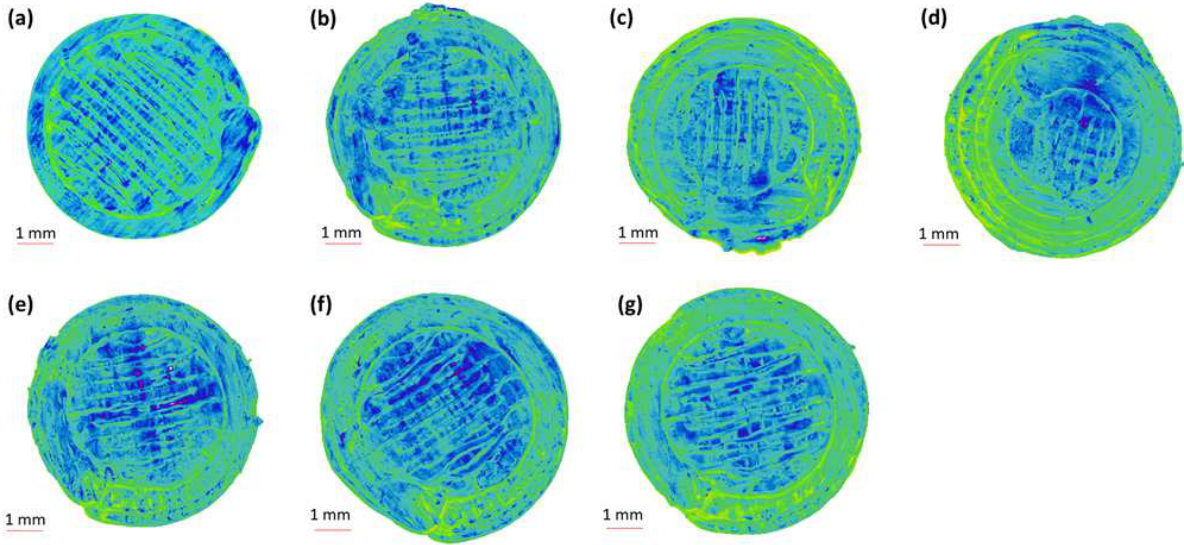
Figure 6. Two-dimensional surface texture images of 3D-printed tablet: ( a ) F1 (1 shell with 0% infill); ( b ) F2 (2 shells with 0% infill); ( c ) F3 (3 shells with 0% infill); ( d ) F4 (4 shells with 0% infill); ( e ) F5 (2 shells with 10% infill); ( f ) F6 (2 shells with 20% infill); and ( g ) F7 (2 shells with 30% infill).